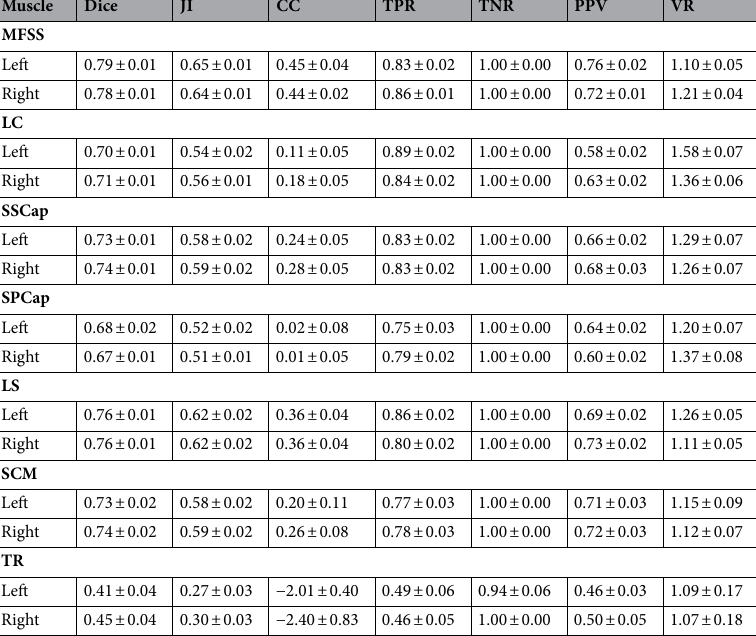
Table 4. CNN segmentation performance metrics. The convolutional neural network (CNN) segmentation performance was further assessed on the testing dataset (n = 18) using the Sørensen-Dice index (Dice), Jaccard index (JI), conformity coefficient (CC), true positive rate (TPR), true negative rate (TNR), positive predictive value (PPV), and volume ratio (VR). Metrics shown = mean ± 1 standard